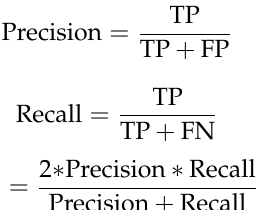
Table 4. Accuracy rates based on different loss functions of various ResNets.